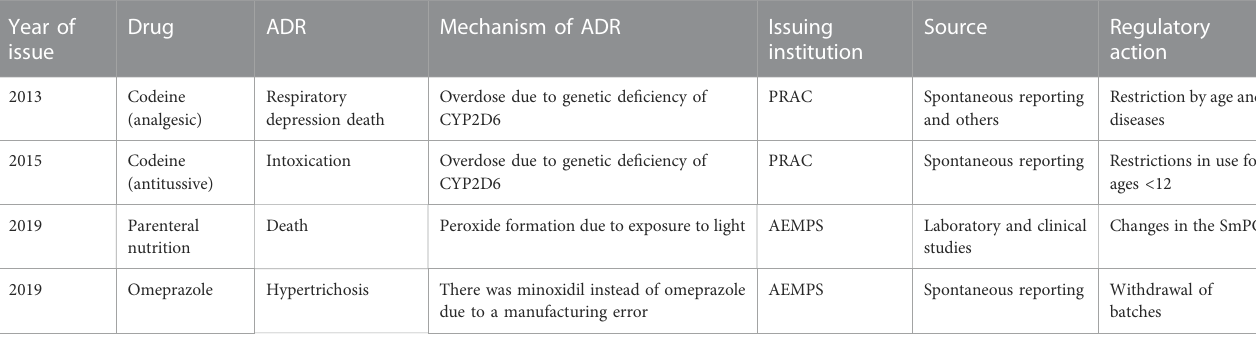
TABLE 6 Characteristics of alerts with drugs addressed to